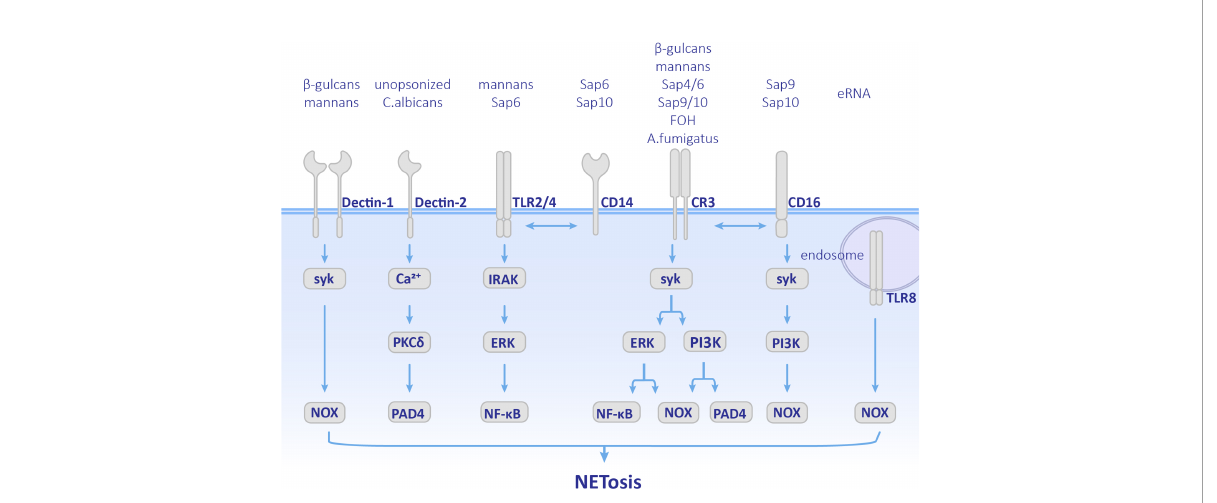
FIGURE 2 Pathways employed by different fungal components. Cellular components involved in NETosis vary depending on different fungal stimulation. Neutrophils recognize by Dectin-1, Dectin-2, TLRs, CD14, CD16 and CR3 receptors, and activate both ROS pathway and ROS-independent pathway. CR3, complement receptor 3; TLR, Toll-like receptor; MPO, myeloperoxidase; ROS, reactive oxygen